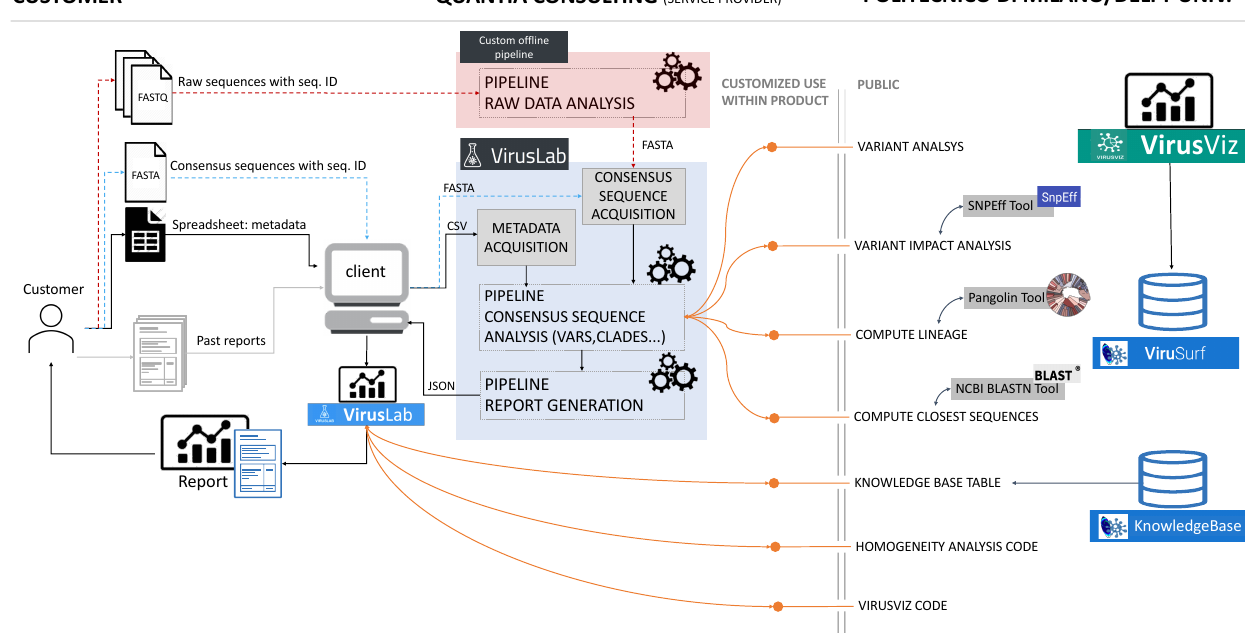
Figure 1. VirusLab architecture. The left part describes users interaction, the central part illustrates the internals of the system, the right part illustrates the open-source services inherited from ViruSurf and